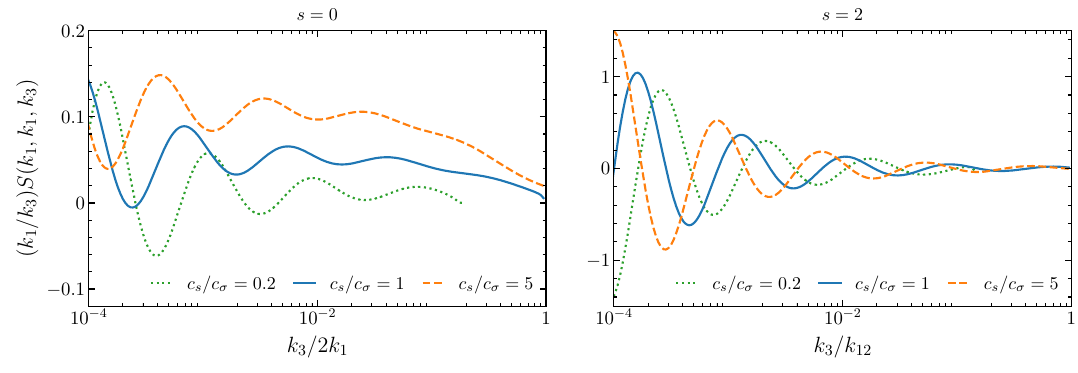
Figure 6 . Shape functions from boost-breaking interactions with nontrivial sound speeds, for scalar exchange ( left ) and spin-2 exchange ( right ) diagrams with µ = 3 . For demonstration we have normalized the amplitudes of the oscillations to be the same size and take the isosceles-triangle configuration with k = k . As the seed functions are valid for u ∈ [0 , 1] , we stop the plots at 1 2 k 3 /k 12 = c s /c σ when c s /c σ < 1 .